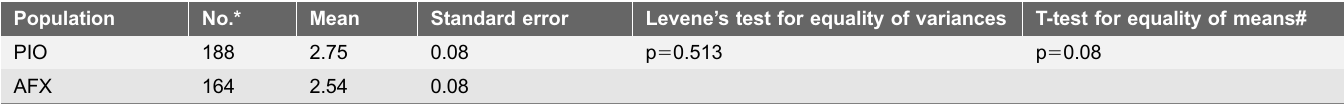
Table 2. Comparison of means and variance of disease severity scores from two F 1 mapping populations (PIO and AFX) inoculated with Verticillium alfalfae . Population